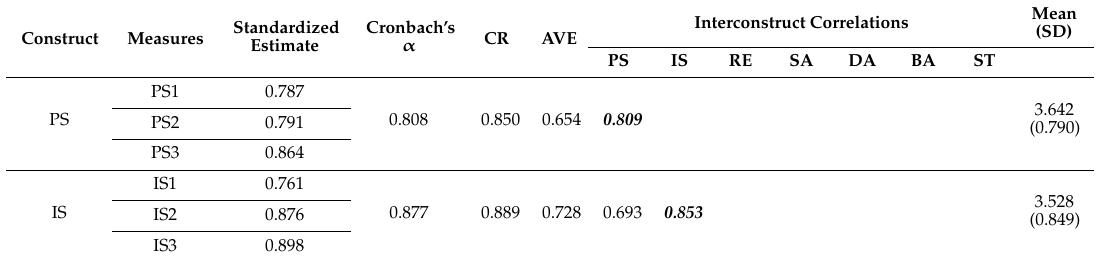
Table 3. Standardized estimate, reliability, and interconstruct